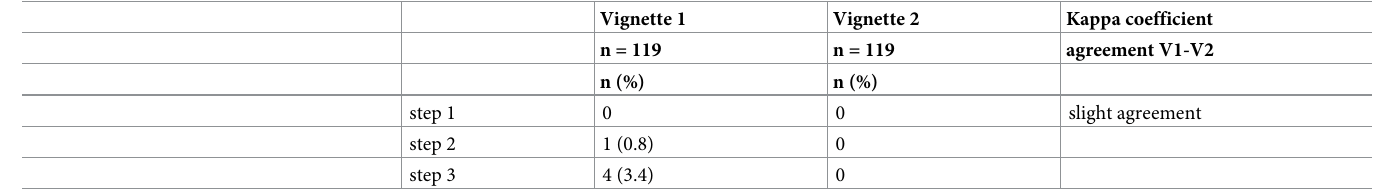
S1 Table. Database of obstetricians